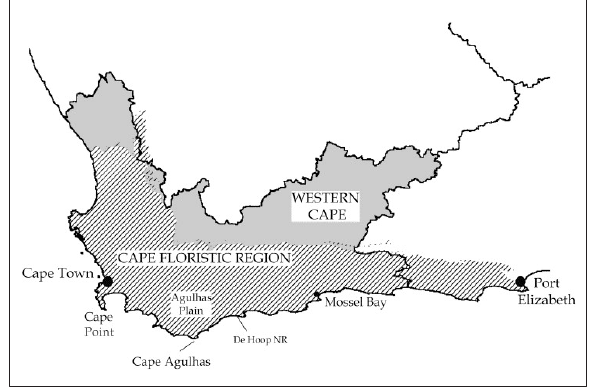
Figure 1: The Cape Floristic Region in relation to the Agulhas Plain, Western Cape Province, South Africa. 3